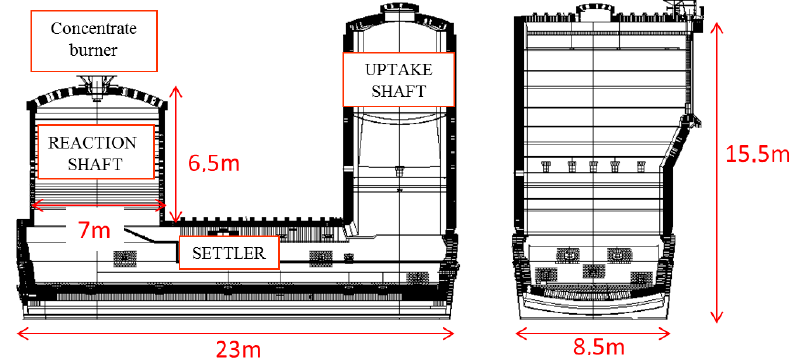
Figure 1. Atlantic copper Outotec FSF dimensions.